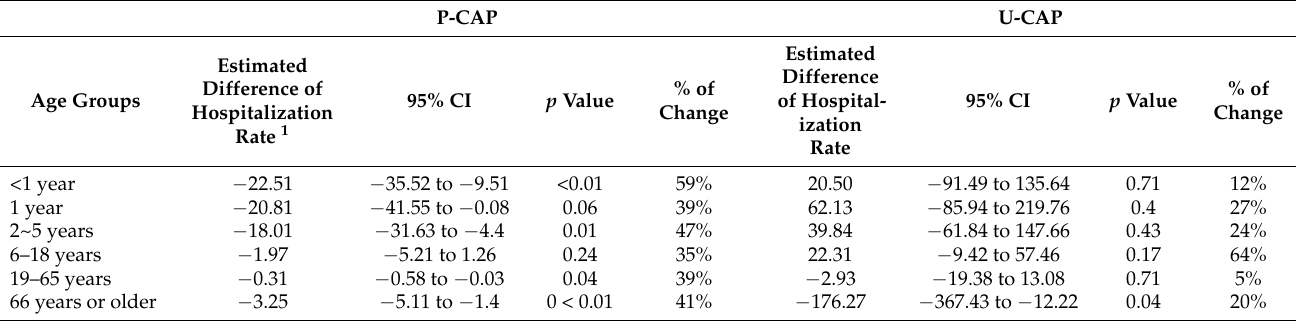
Figure 3. Trends of hospitalization rate due to pneumococcal and unspecific community-acquired pneumonia before and after vaccination. Trends in hospitalization rates before (hollow dots and solid trend line) and after (plus sign and broken trend line) vaccination program roll-out in 2013. For pneumococcal CAP (P-CAP) in children aged ( a ) <1 year, ( b ) 1 year, and ( c ) 2–5 years, ( d ) 6–18 years, adults aged ( e ) 19–65 years, ( f ) 66 years, or older, and unspecific CAP (U-CAP) in children aged ( g ) <1 year, ( h ) 1 year, and ( i ) 2–5 years, ( j ) 6–18 years, adults aged ( k ) 19–65 years, ( l ) 66 years, or older. The vertical line indicates the PCV13 intervention in 2013. The labels of x-axis: sp—spring; su—summer; fa—fall; wi—winter. Table 1. Estimated difference of hospitalization incidence rate between pre- (2005–2012) and post-vaccination period (2013–2016) among patients with pneumococcal or unspecific community-acquired pneumonia by age groups.